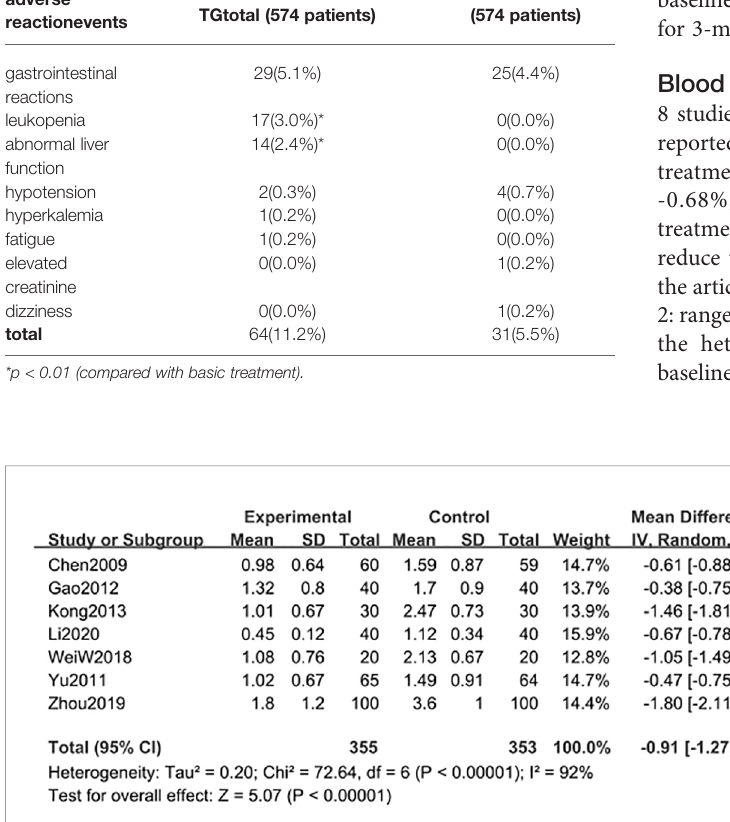
FIGURE 7 | 24 h-UTP level after 6 months: comparison of treatment combined with TG against basic